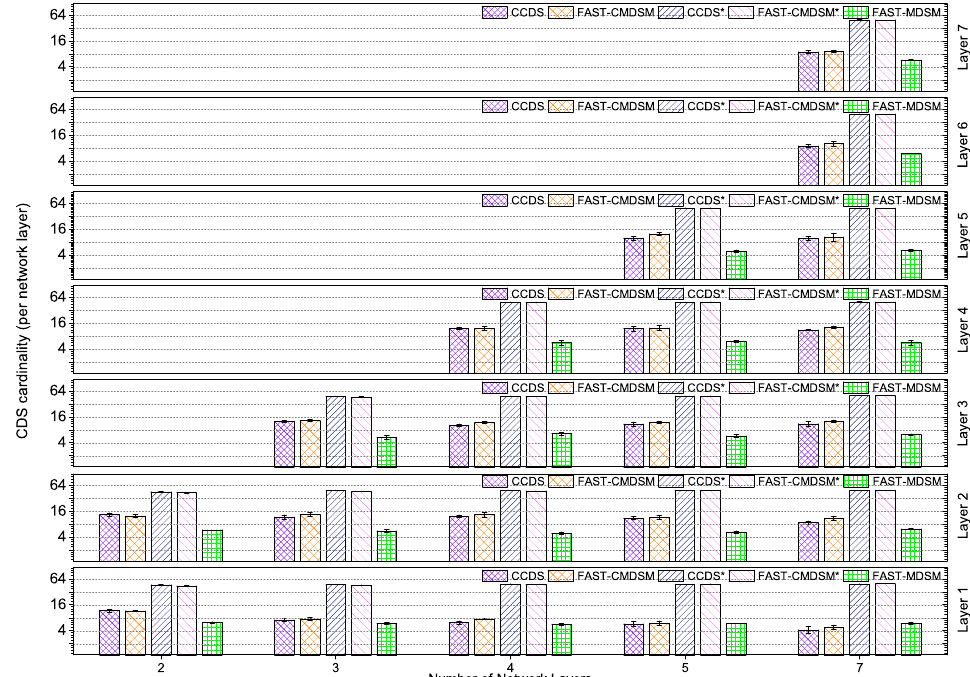
Figure 11. Impact of number of layers (Low skewness).